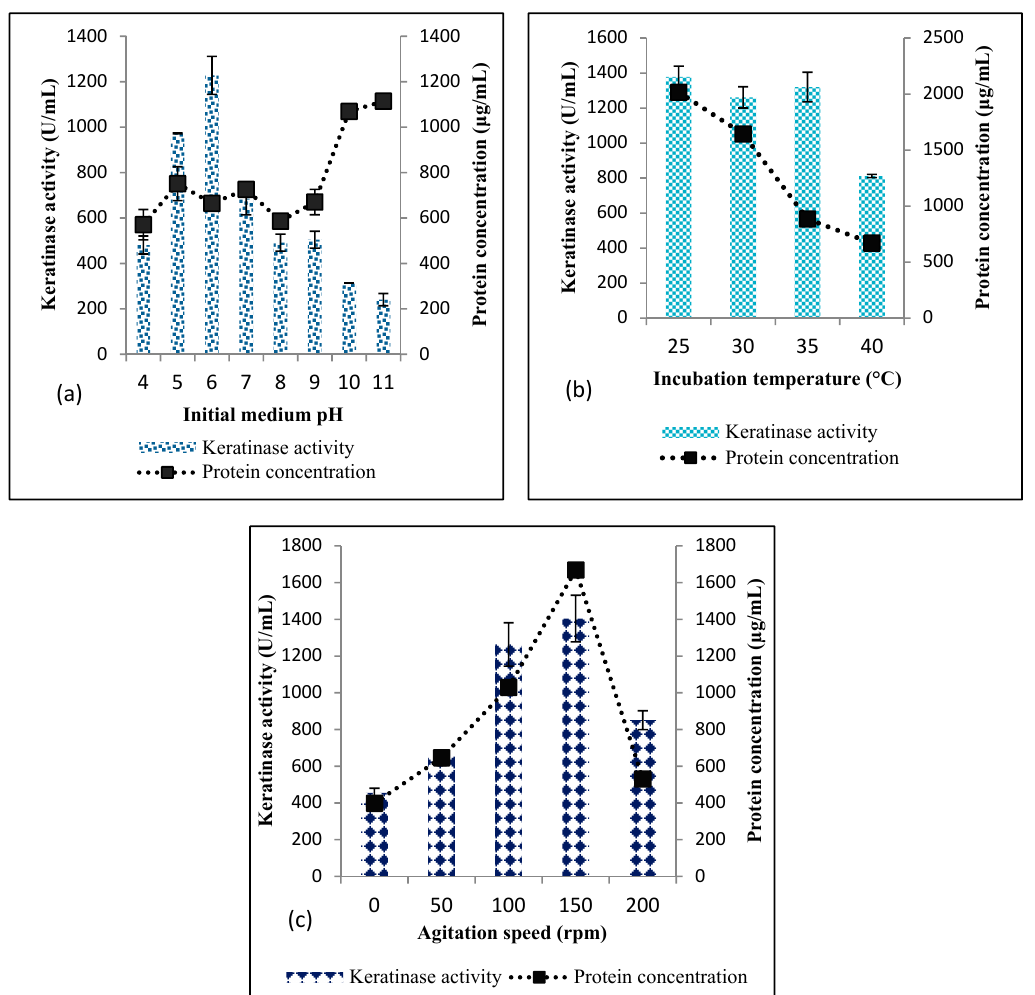
Figure 1. Effects of ( a ) initial medium pH ( b ) incubation temperature ( c ) agitation speed on keratinase production by Bacillus sp. Nnolim-K1. Each point represents the mean and standard deviation of triplicate experiments.